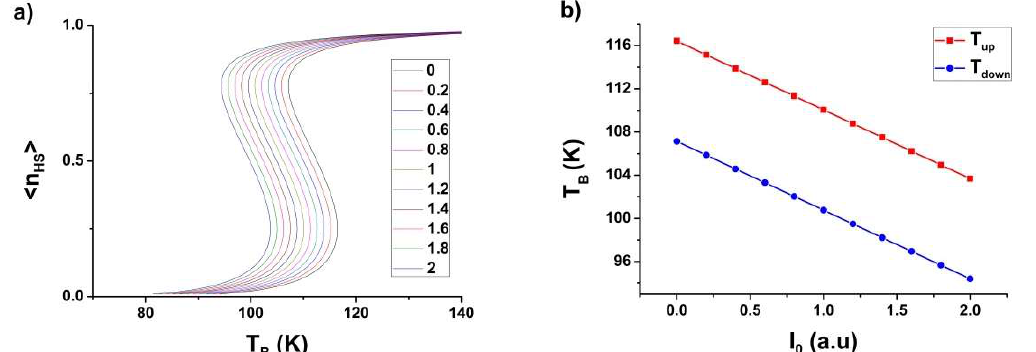
Figure 10. ( a ) Simulated bath-temperature (T B ) dependence of the HS fraction under various light intensities (given in arbitrary units) including the effect of light absorption. ( b ) Light intensity dependence of the upper and lower transition temperatures of the thermal hysteresis. Used parameter values are: J = 155 K, ∆ = 394 K, g = 1097, C LS p = 0.1 a.u. (arbitrary unit), and C HS p = 0.1 a.u., δ = 1 a.u., L = 1 a.u.